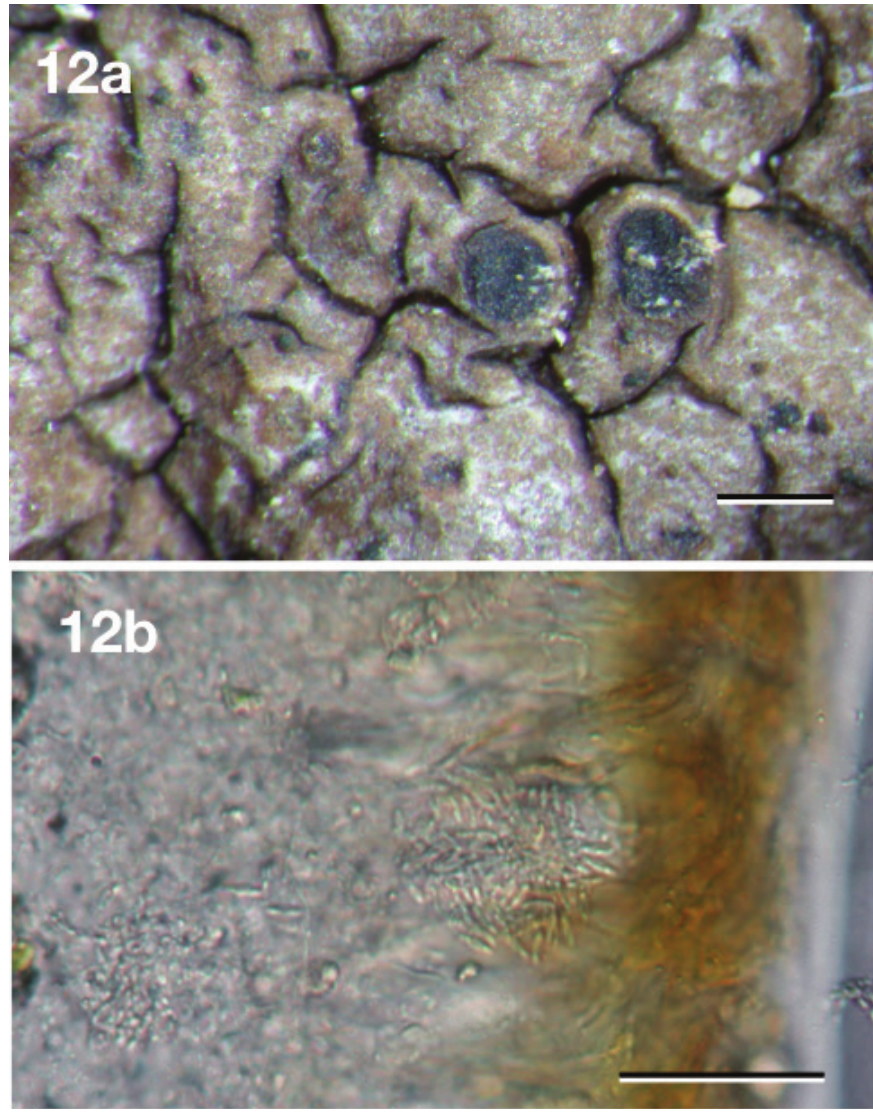
Figure 12. Neoprotoparmelia plurisporibadia , holotype Cáceres & Aproot 22130 (ABL). a Habitus b ascus with ascospores. Scale bars: 1 mm ( a ), 10 micron ( b ). to erumpent, usually up to one per areole, initially round, later usually compressed and with wavy elongated shape, 0.4–1.3 mm diam., disc concave to flat, smooth, glossy, dark brown. Margin dull, ca. 0.3 mm wide, indistinguishable from the thallus, not or only slightly higher than the disc. Hymenium hyaline, not inspersed with oil droplets, up to 100 μm high; epihymenium fuscous brown, pigment in KOH becoming soluble and paler; hypothecium hyaline, not distinguishable from the thallus medulla and thus extending to over 1 mm; excipulum hyaline throughout, with a 10–15 μm thick